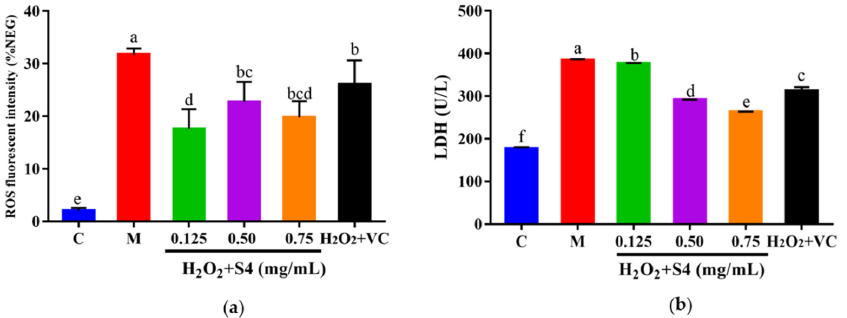
Figure 6. Effects of S4 on ( a ) ROS level and ( b ) LDH level of cells with oxidative stress. “C” represents the control group, and “M” represents the model group. Data were expressed as mean ± SD ( n ≥ 3, p < 0.05). Different letters indicate significant differences ( p < 0.05).